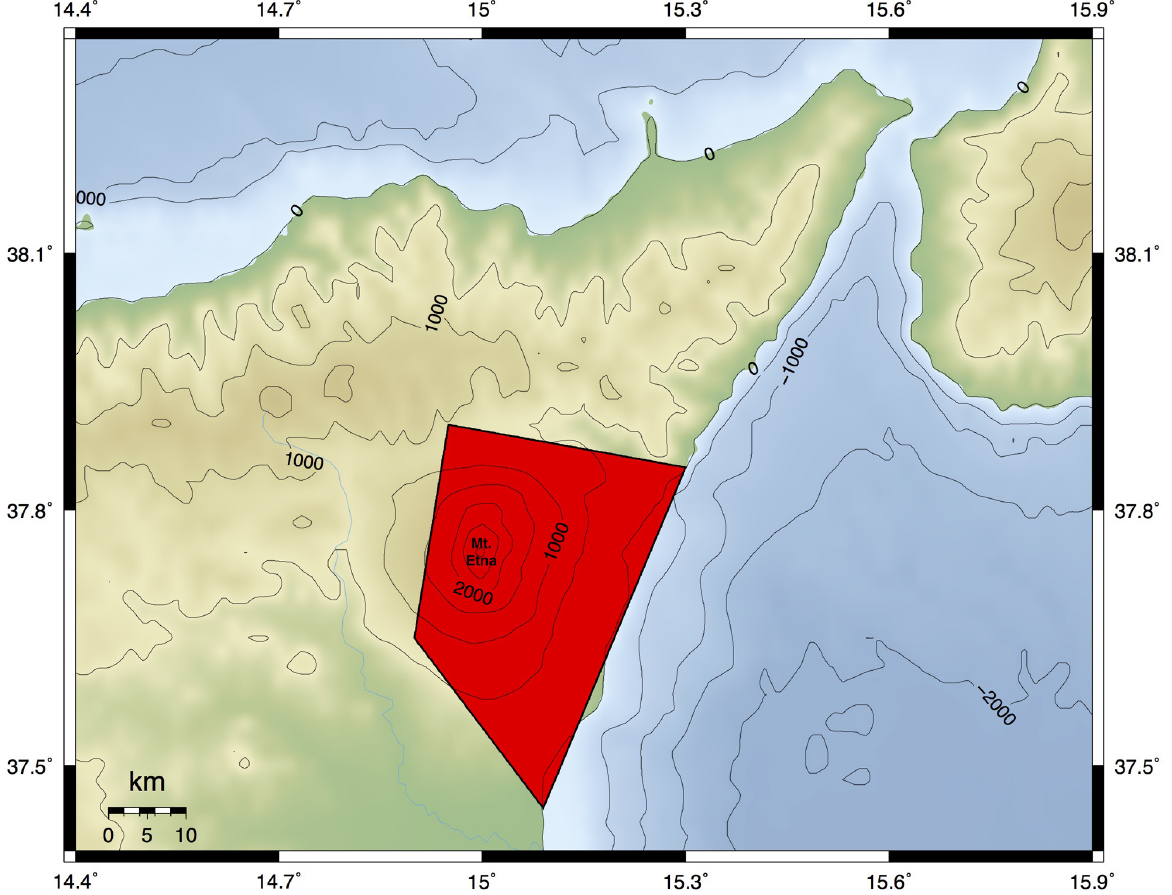
Figure 8. Area of elevated scattering caused by increased